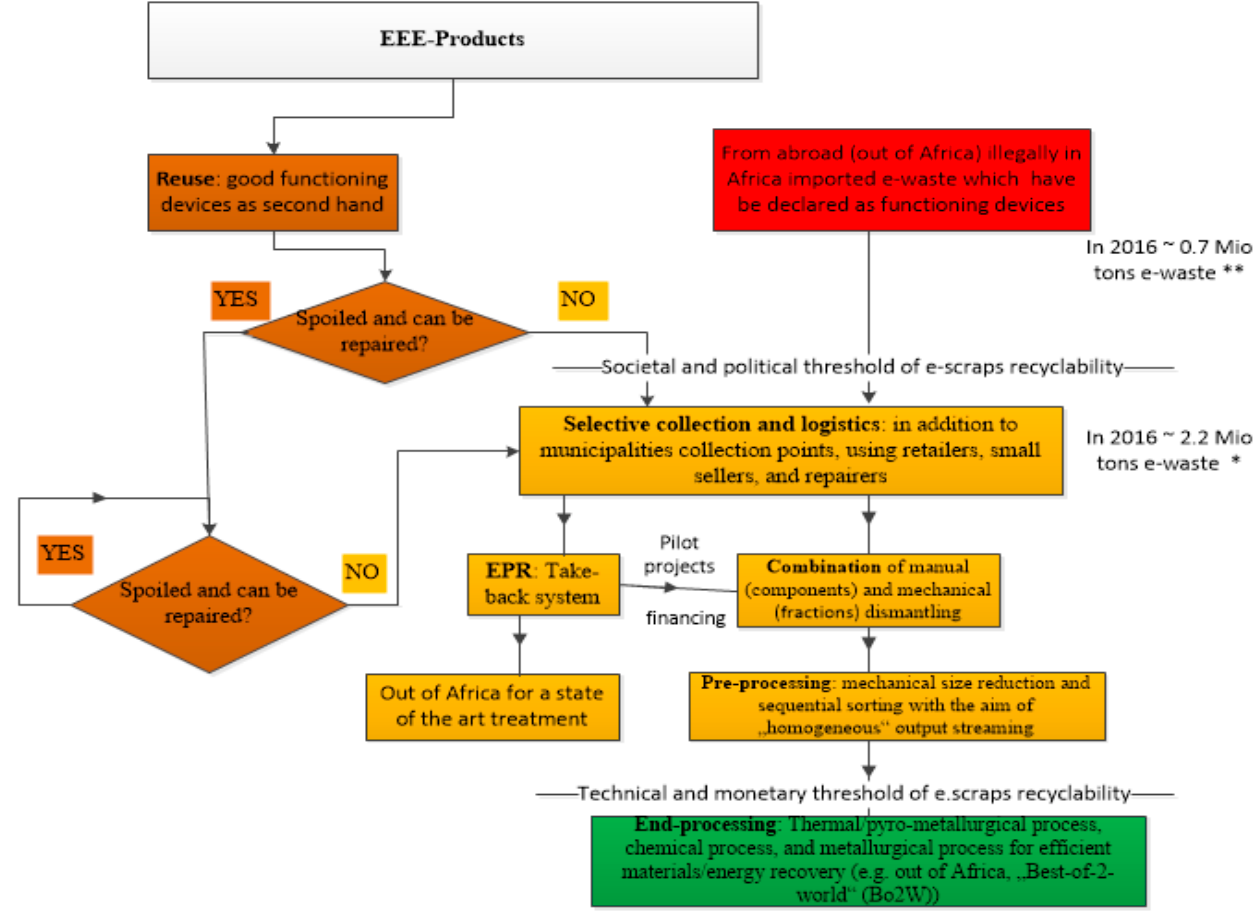
Figure 4. E-waste management strategy for Africa (improvement on current practice). Source for * [33] and for ** we assume that around 1/3 of the 2.2 Mt e-waste in Africa in 2016 was illegal importation.